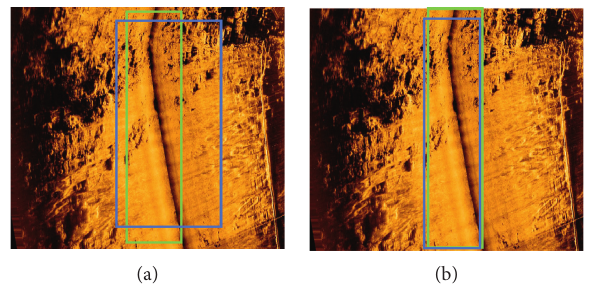
Figure 10: Comparison of positioning accuracy in test